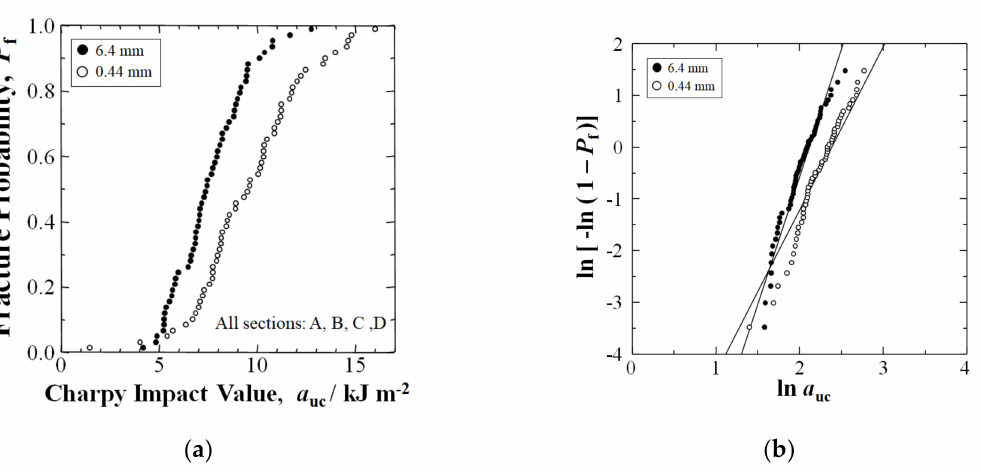
Figure 4. ( a ) Relationship between Charpy impact value, auc, and fracture probability, Pf, for nominal 6.4 mm and extended mixing 0.44 mm samples in a GFRP-BMC compression-molded panel, with the cumulative of Sections A, B, C and D equaling 56 samples each of the 6.4 and 0.44 mm fiber length sample data sets, respectively; ( b ) Weibull 2-parameter plots of data in ( a